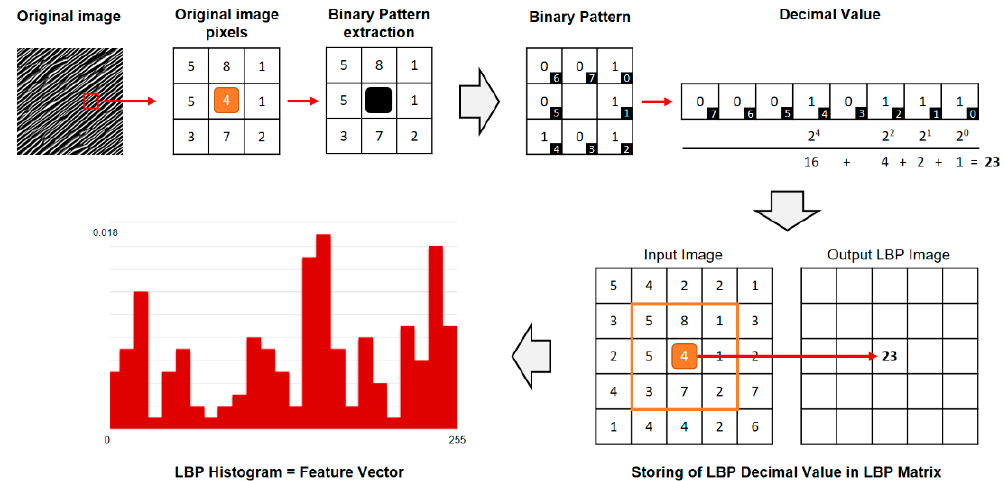
Figure 4. Visualization of calculation of Local Binary Pattern (LBP): An example region of the original image is examined, with neighboring parameters of R = 1 and N = 8. Neighboring pixels are compared to the center pixel: pixel values smaller than the center pixel values are assigned to 1, pixel values bigger to 0. Binary values are stringed together. This allows a calculation of a decimal value which will be stored in matrix with the same width and height as the original image and in the same place as the input center pixel. This is done for every pixel of the image. The LBP matrix can be represented as a histogram which will be treated as the feature vector of the original image.